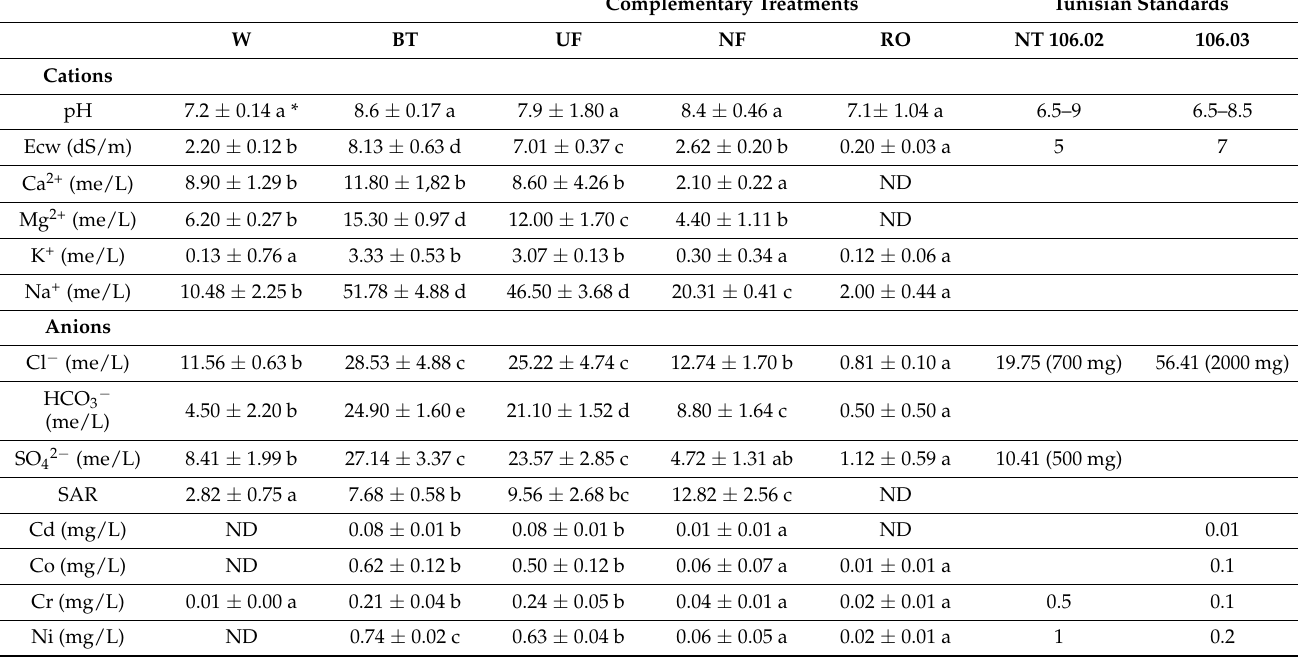
Table 2. Characterization of the well water (W) and the TTE. The average values are compared to